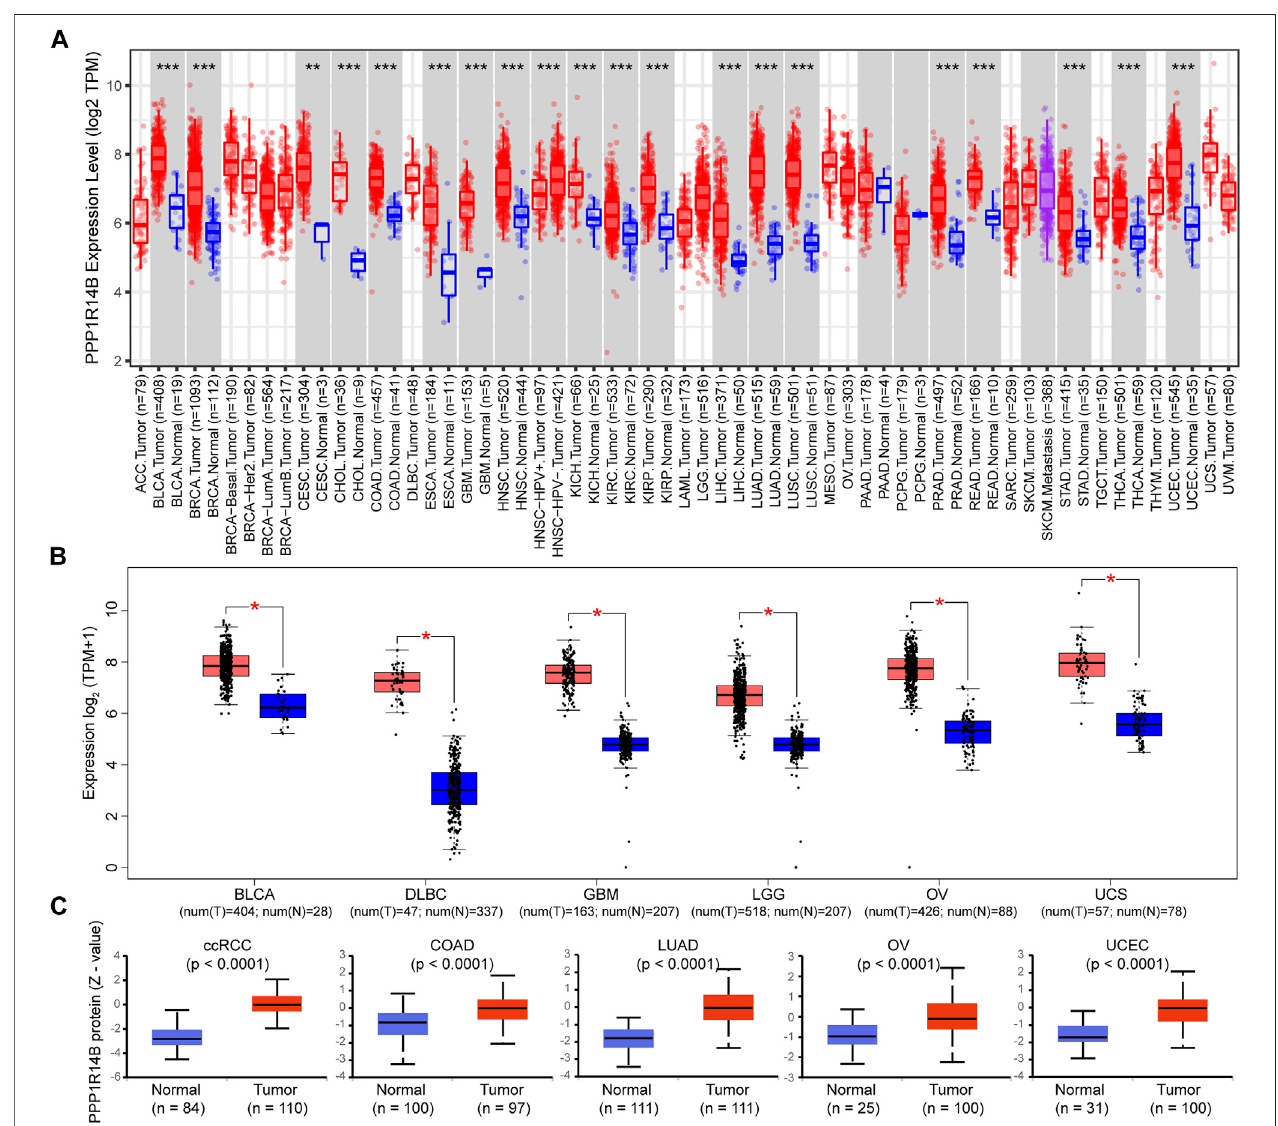
FIGURE2| mRNAexpressionlevelofPPP1R14Binpan-cancer. (A) HumanPPP1R14BexpressionlevelsindifferentcancertypesfromTCGAdatainTIMER.** p < 0.01, *** p < 0.001 (B) For the type of BLCA, DLBC, GBM, LGG, OV, and UCS in the TCGA project, the normal tissues of the GTEx database were included as controls. The box plot data were supplied. ** p < 0.01. (C) PPP1R14B proteomic expression pro fi le in ccRCC, COAD, LUAD, OV, and UCEC from CPTAC samples. Z-values represent standard deviations from the median across samples for the given cancer type. N represents the number of samples.